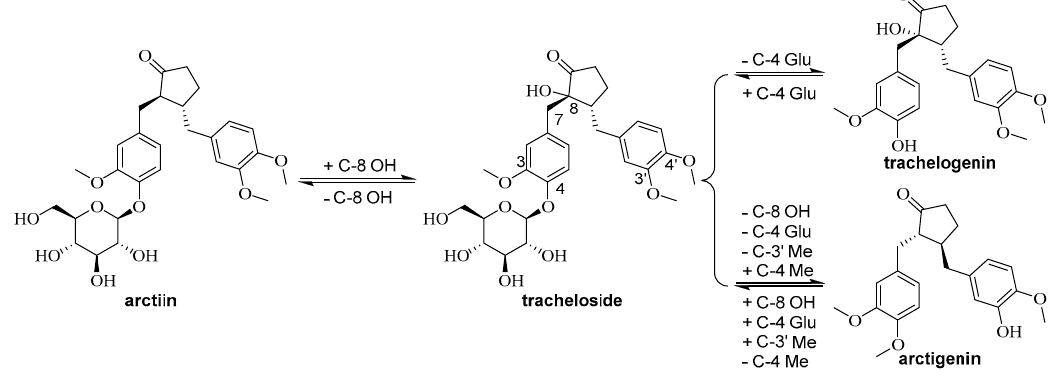
Figure 7. Transformation of representative lignans from Trachelospermum.